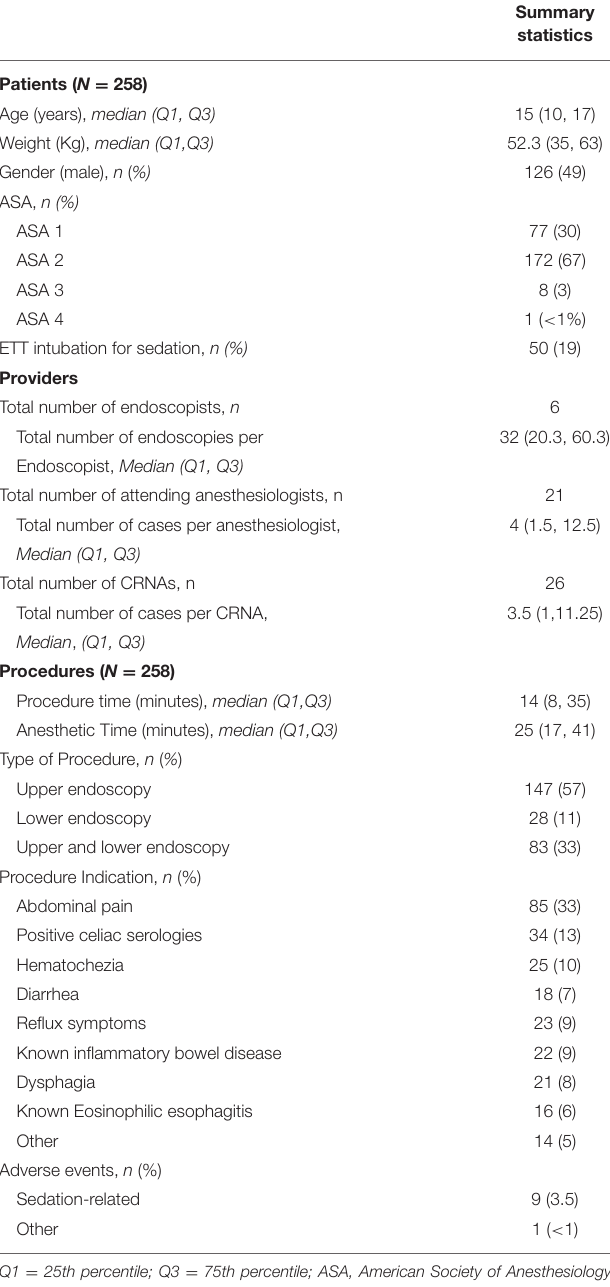
TABLE 1 | Descriptive characteristics of patients, providers and